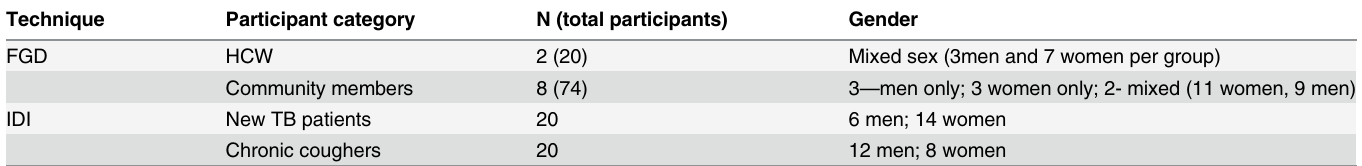
Table 1. Data collection techniques, study participants and sample